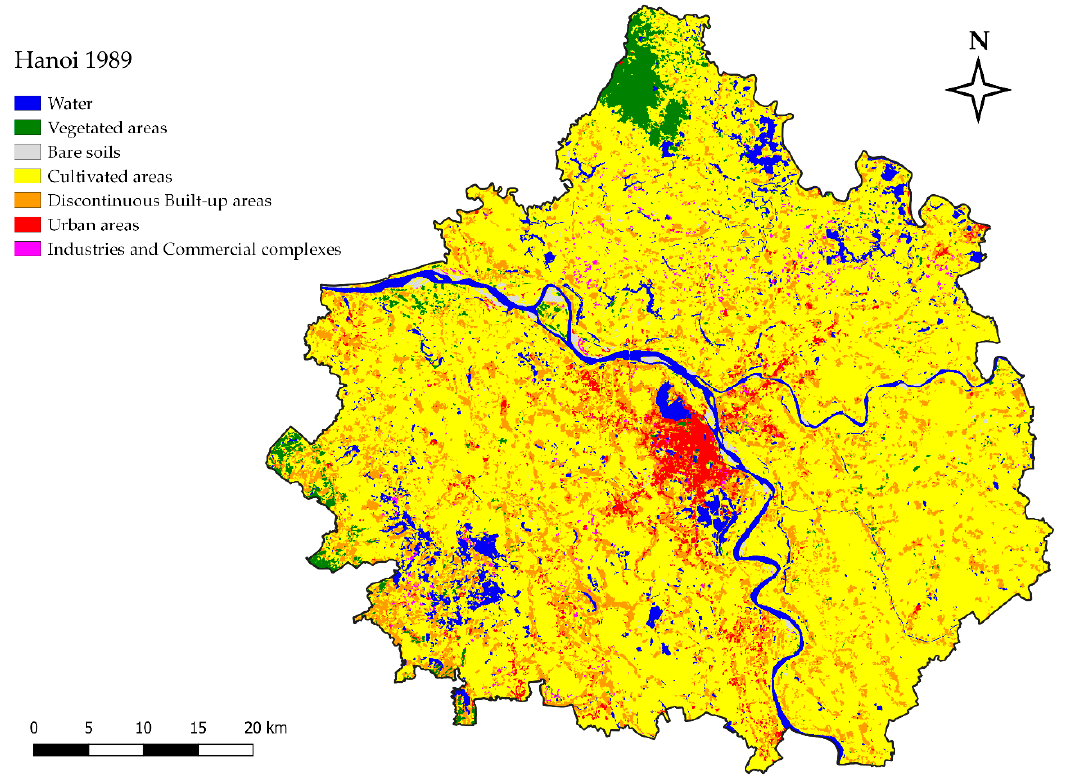
Figure 6. The 1989 LULC map of the study area.